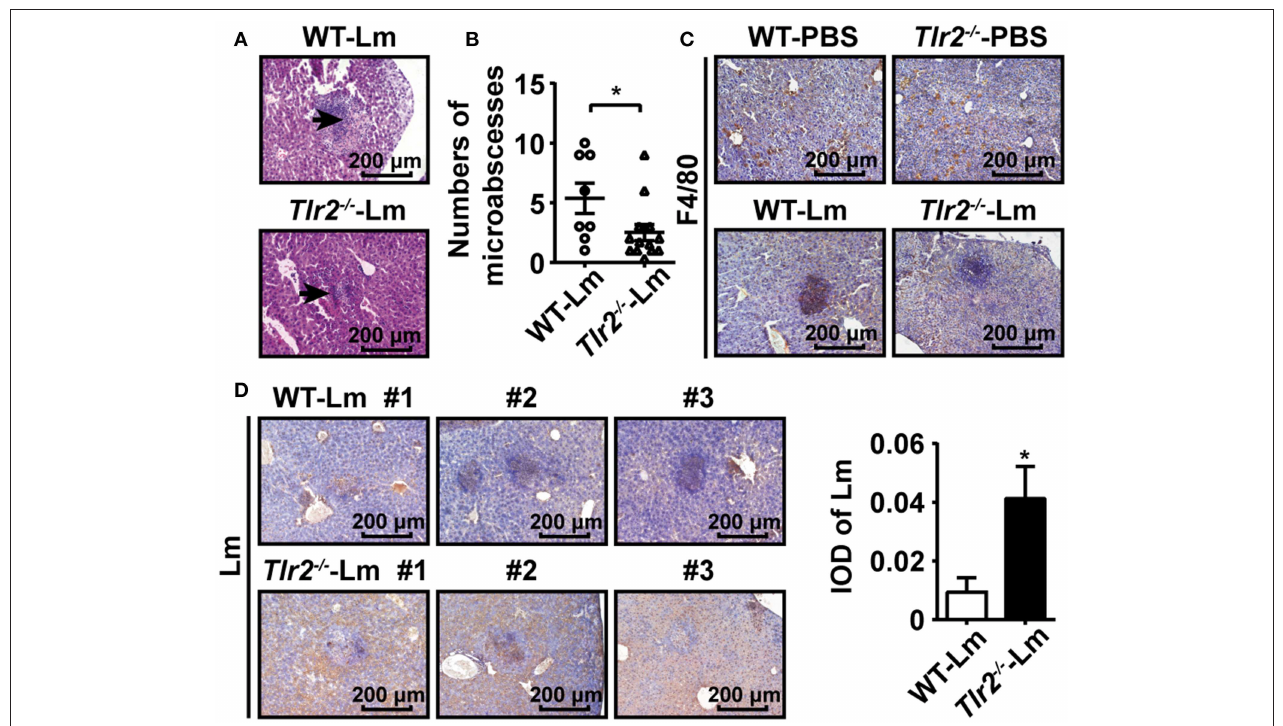
FIGURE 5 | TLR2 contributes to hepatic microabscess formation. (A) Pathological sections (H&E staining) of livers obtained from Lm-infected WT and Tlr2 − / − mice 2 dpi. Black arrows indicate microabscesses. One representative image of three independent experiments is shown. (B) The total number of microabscesses in the liver of Lm-infected WT and Tlr2 − / − mice 2 dpi ( n ≥ 8). The number of microabscesses was quantified by counting the lesions presented in 18 fields on each section. (C,D) IHC was performed for F4/80 (C) and Lm ( D , left) in the livers of WT and Tlr2 − / − mice ( n = 5). The level of Lm was analyzed by IOD ( D , right). One representative image of three independent experiments. Data are presented as the mean ± SEM. * p <